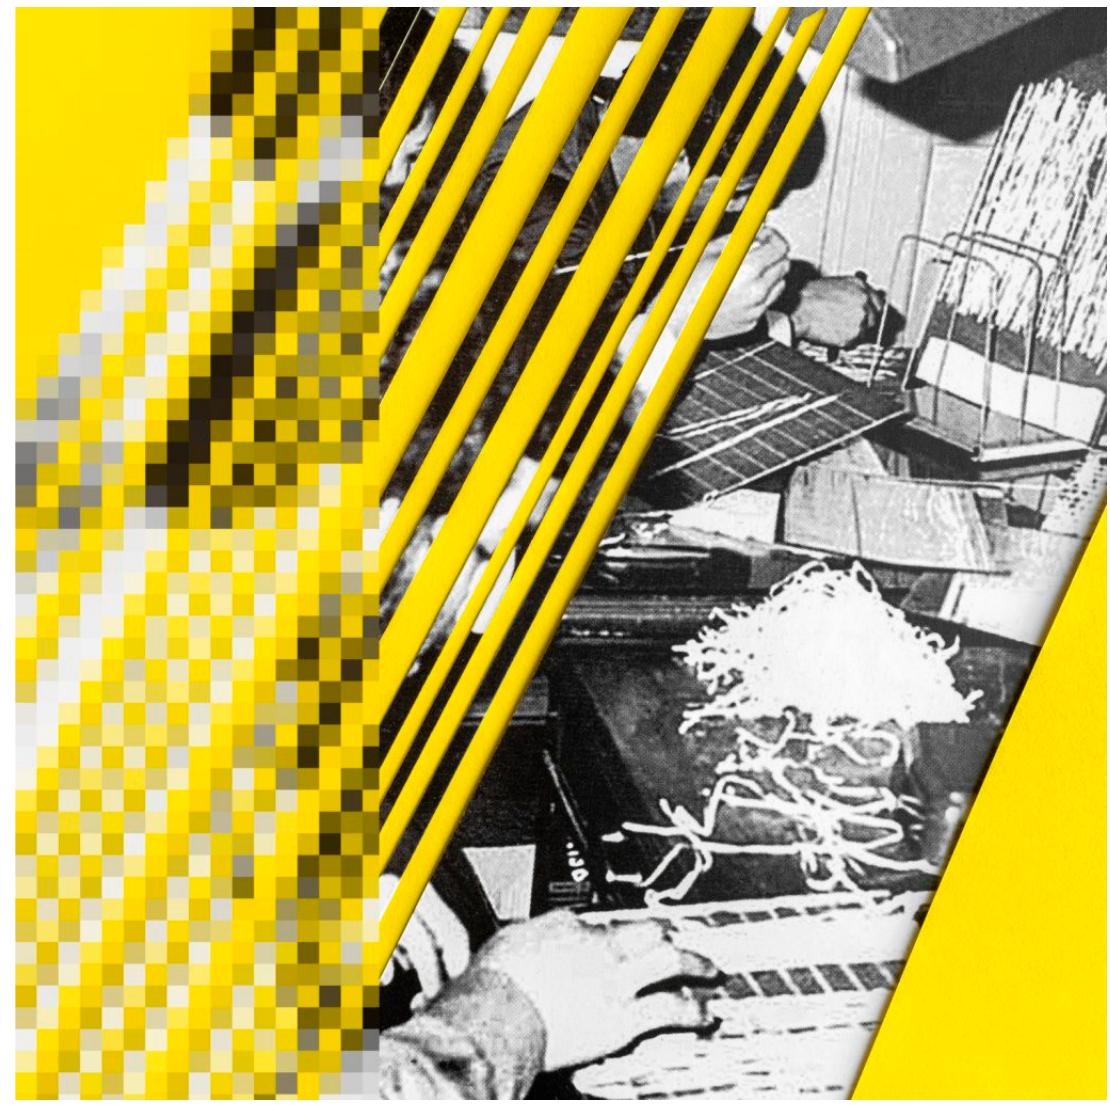
Figure 6. Parham Taghioff, From the Asymmetrical Authority series, 2018, photographs, HD inkjet print on archival acid-free paper, 50 × 50 cm.